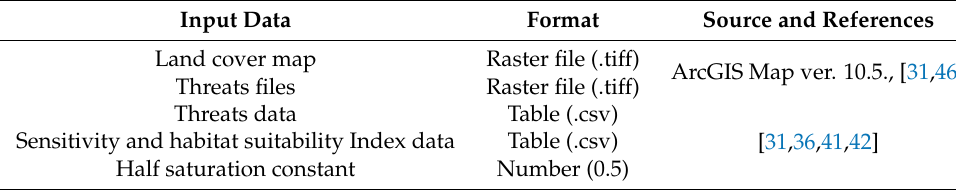
Table 4. Input data and Format of the InVEST Habitat Quality